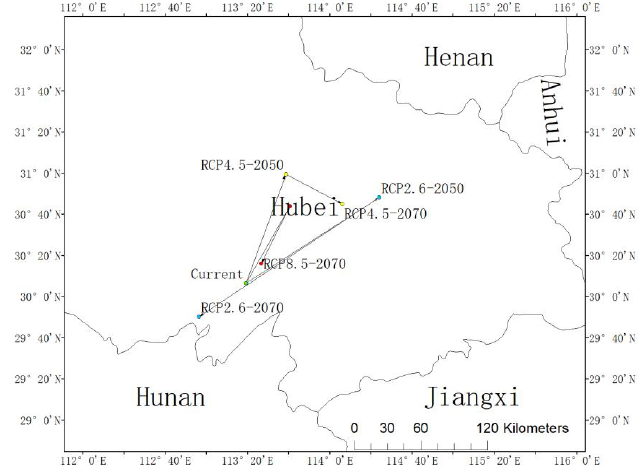
Figure 4. The core distributional shifts of Liriodendron chinense under different climate scenarios in China.